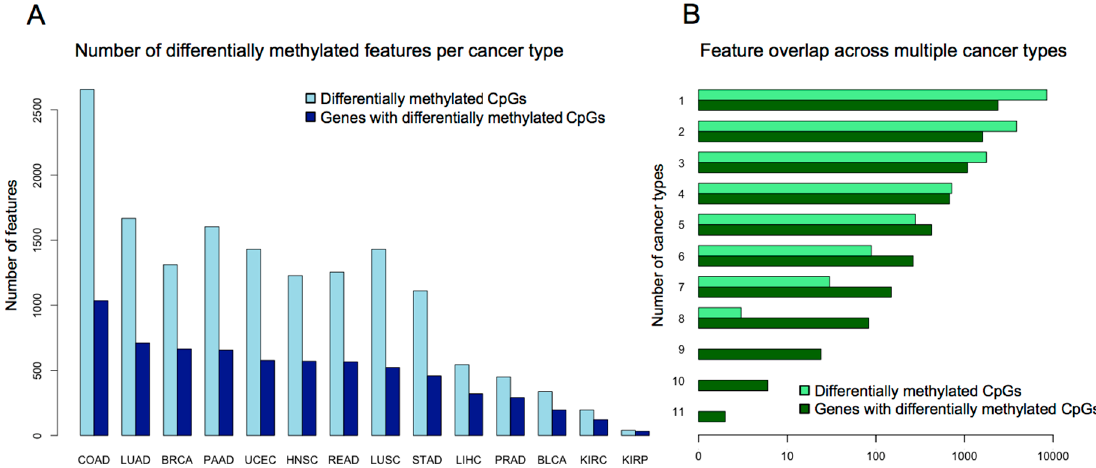
Figure 2. Number of differentially methylated genomic loci across cancers: ( A ) Figure generated using data from [62]. The vertical axis represents total count. For each cancer, the differentially methylated CpGs were defined as those with average methylation levels above 25% in tumors and less than 5% in controls; ( B ) Figure generated using data from [62]. The horizontal axis represents the number of features (either differentially methylated CpGs or genes that contain differentially methylated CpGs) that are shared by a number of cancer types that is greater than or equal to the value shown in the vertical axis. COAD: colon adenocarcinoma; LUAD: lung adenocarcinoma; BRCA: breast invasive carcinoma; PAAD: pancreatic adenocarcinoma; UCEC: uterine corpus endometrial carcinoma; HNSC: head and neck squamous cell carcinoma; READ: rectum adenocarcinoma; LUSC: lung squamous cell carcinoma; STAD: stomach adenocarcinoma; LIHC: liver hepatocellular carcinoma; PRAD: prostate adenocarcinoma; BLCA: bladder urothelial carcinoma; KIRC: kidney renal clear cell carcinoma; KIRP: kidney renal papillary cell carcinoma.